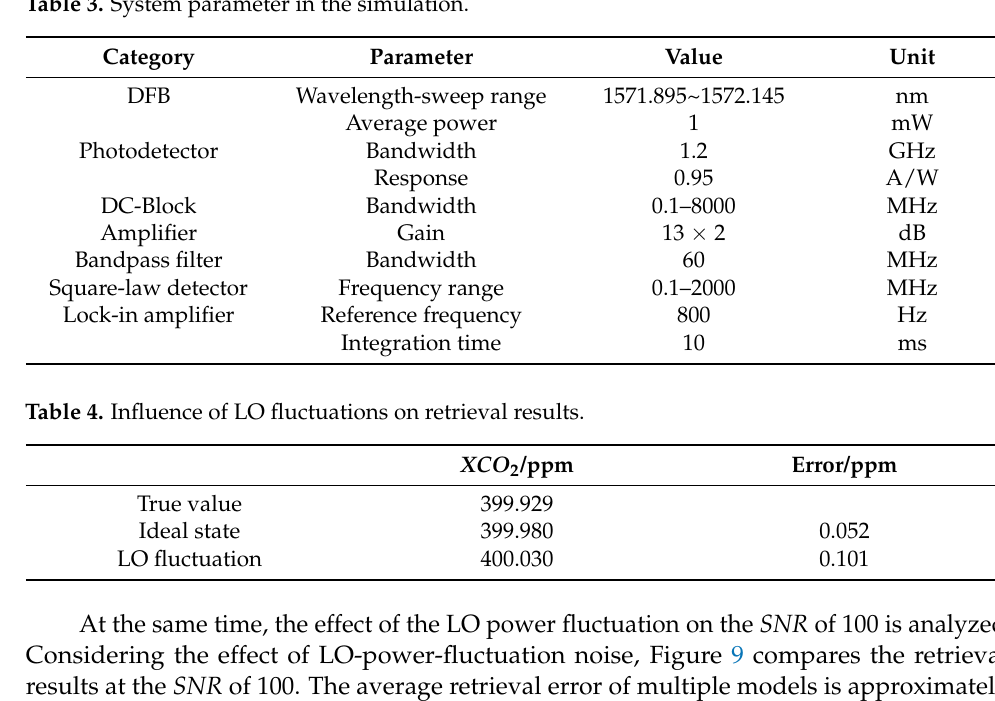
Table 3. System parameter in the simulation.